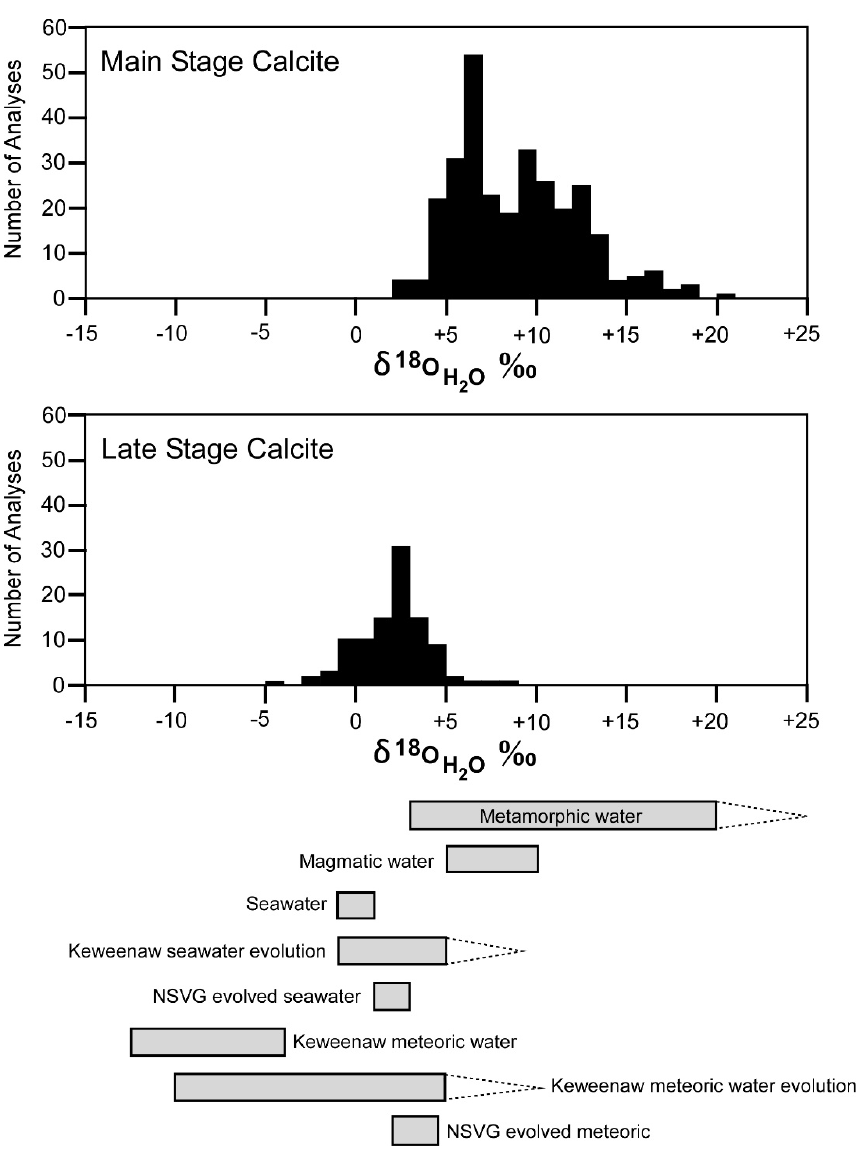
Figure 7. Histogram of oxygen isotopic composition of calcite from the Keweenaw Peninsula native copper district. Oxygen isotopic composition of various types of water given below in shaded boxes with open area denoting possible higher values. Metamorphic water [51,57], magmatic [15], seawater [51], Keweenaw seawater evolution [51,58], North Shore Volcanic Group (NSVG) evolved seawater [58], Keweenaw meteoric water [6,58]. Keweenaw meteoric water evolution [6,51,58], and North Shore Volcanic Group (NSVG) [58]. Analytical and temperature uncertainty is shown in Figure 5. Temperature uncertainty is discussed in Sections 4.3 and 6.5.